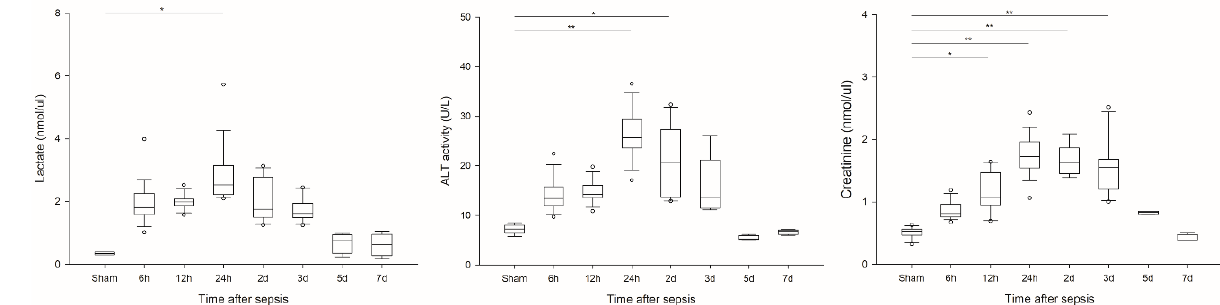
Figure 4. Serial change of plasma lactate, serum ALT, and creatinine: ( a ) Plasma lactate (sham n = 2, 6 h n = 18, 12 h n = 12, 24 h n = 16, 2 D n = 11, 3 D n = 10, 5 and 7 D n = 4); ( b ) serum ALT (sham n = 5, 6 h n = 15, 12 h n = 12, 24 h n = 16, 2 D n = 10, 3 D n = 8, 5 and 7 D n = 4); ( c ) serum creatinine (sham n = 14, 6 h n = 18, 12 h n = 12, 24 h n = 16, 2 D n = 9, 3 D n = 10, 5 and 7 D n = 4). ** p < 0.001 and * p < 0.05 compared with the sham group. ALT: Alanine